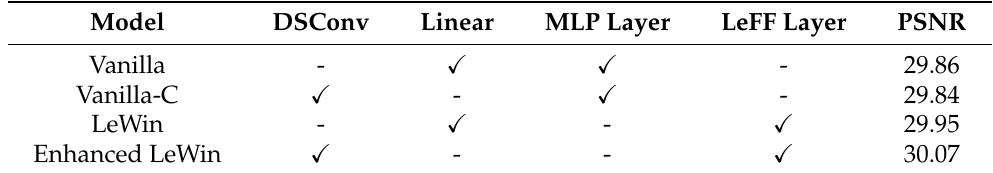
Table 5. Ablation study of FFN layer on Kodak24 .